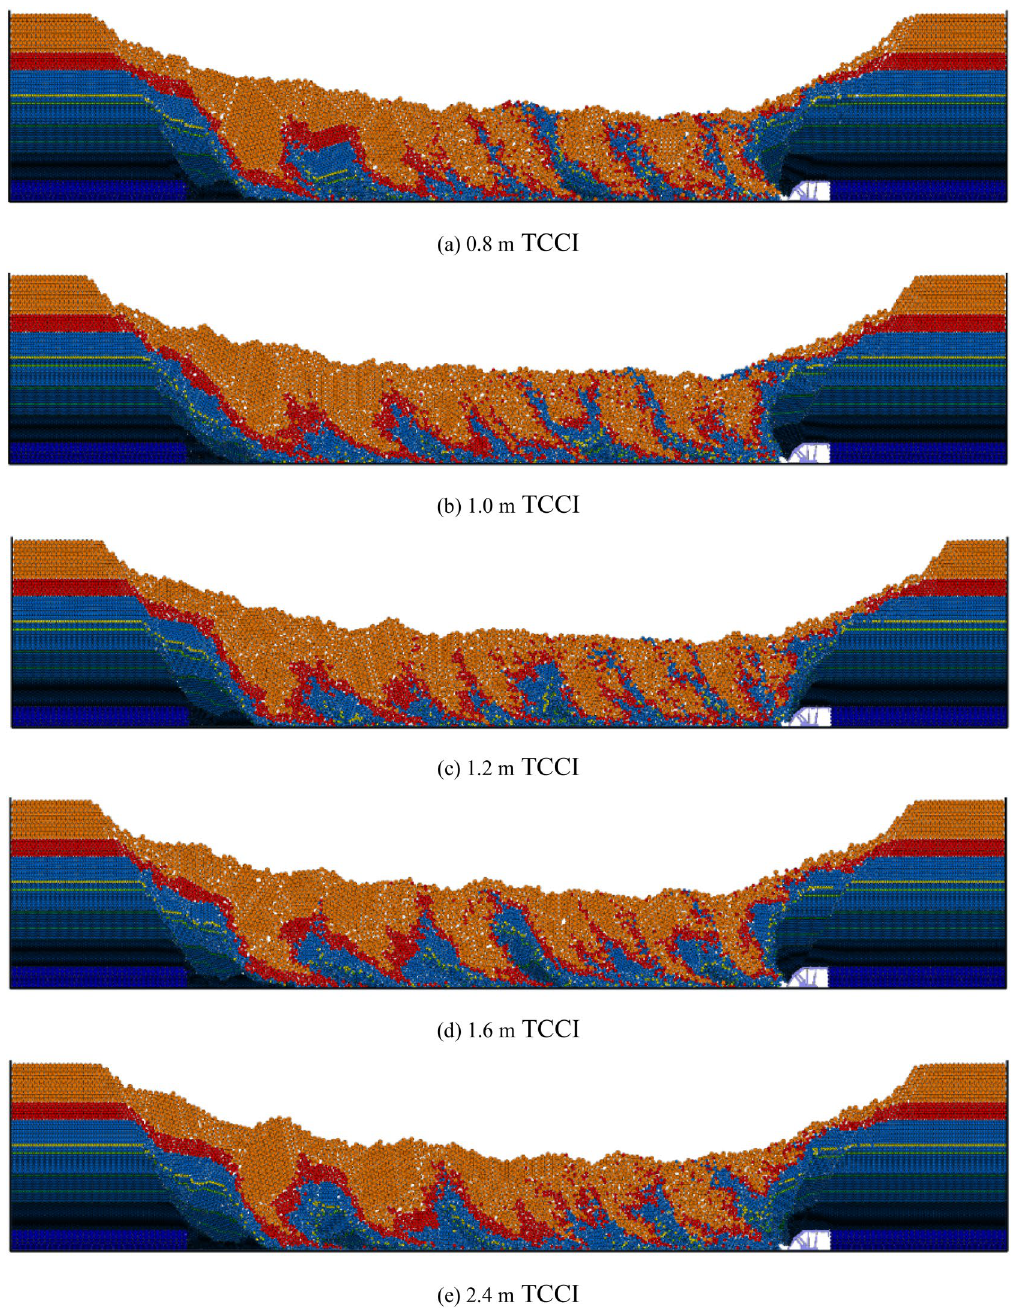
Figure 8. Loss of top coal in different coal-drawing interval under 20.0 m top coal